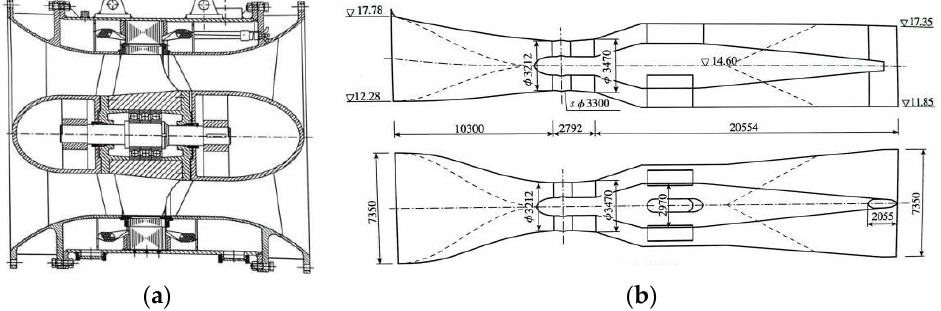
Figure 1. Tubular pump device [8]. ( a ) Full tubular pump unit; ( b ) rear-bulb tubular pump device.